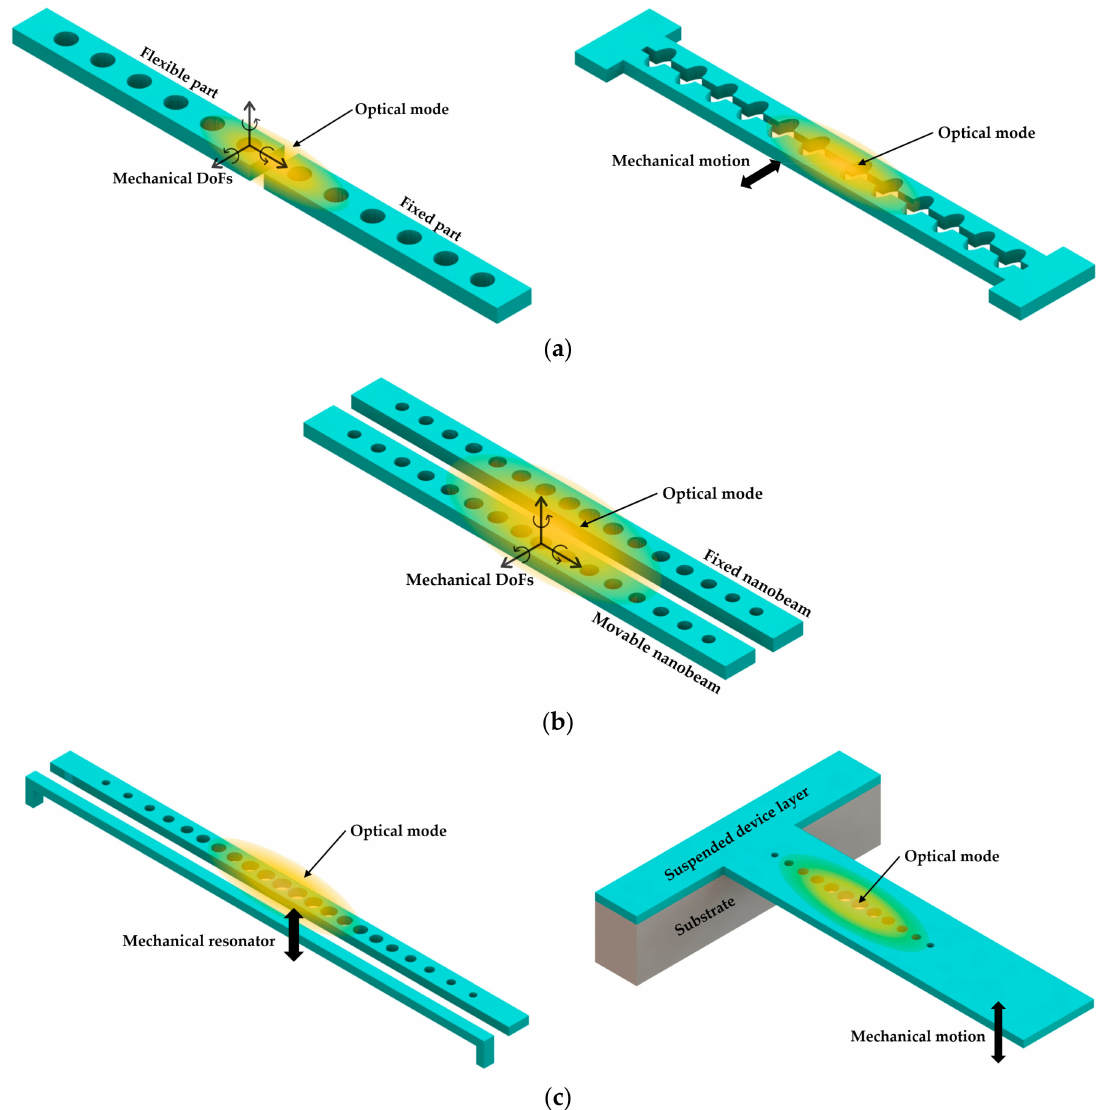
Figure 15. Schematics of potential optomechanical systems based on PhC nanobeam cavities: ( a ) single nanobeam cavity; ( b ) coupled nanobeam cavities; ( c ) nanobeam cavity coupled with a mechanical